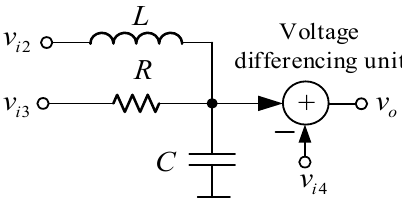
Figure 4. Method to design the proposed biquad filter.